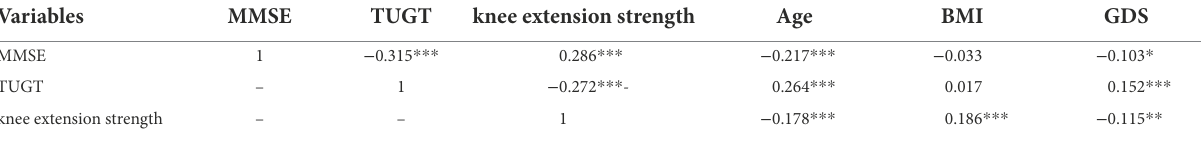
TABLE 4 Correlation between MMSE, TUGT, knee extension strength, and other covariates.